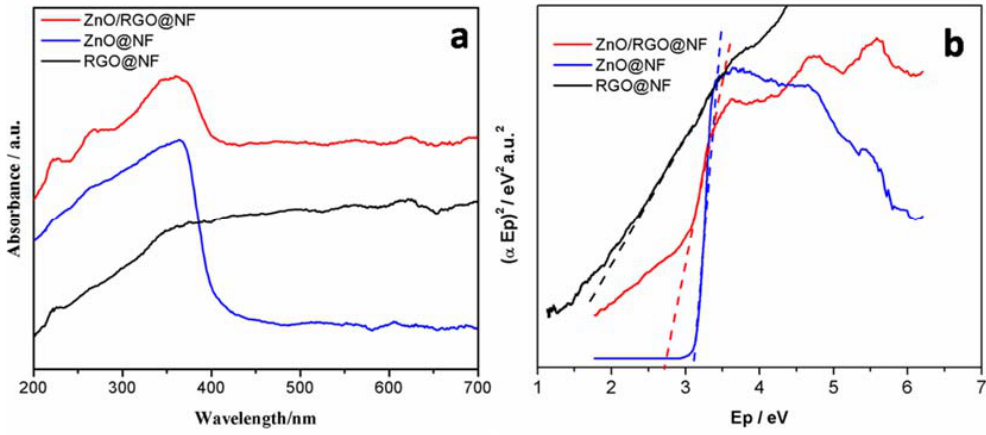
Figure 5. ( a ) UV-vis absorption spectra and ( b ) Tauc plots showing band gap of RGO/NF, ZnO/NF, and